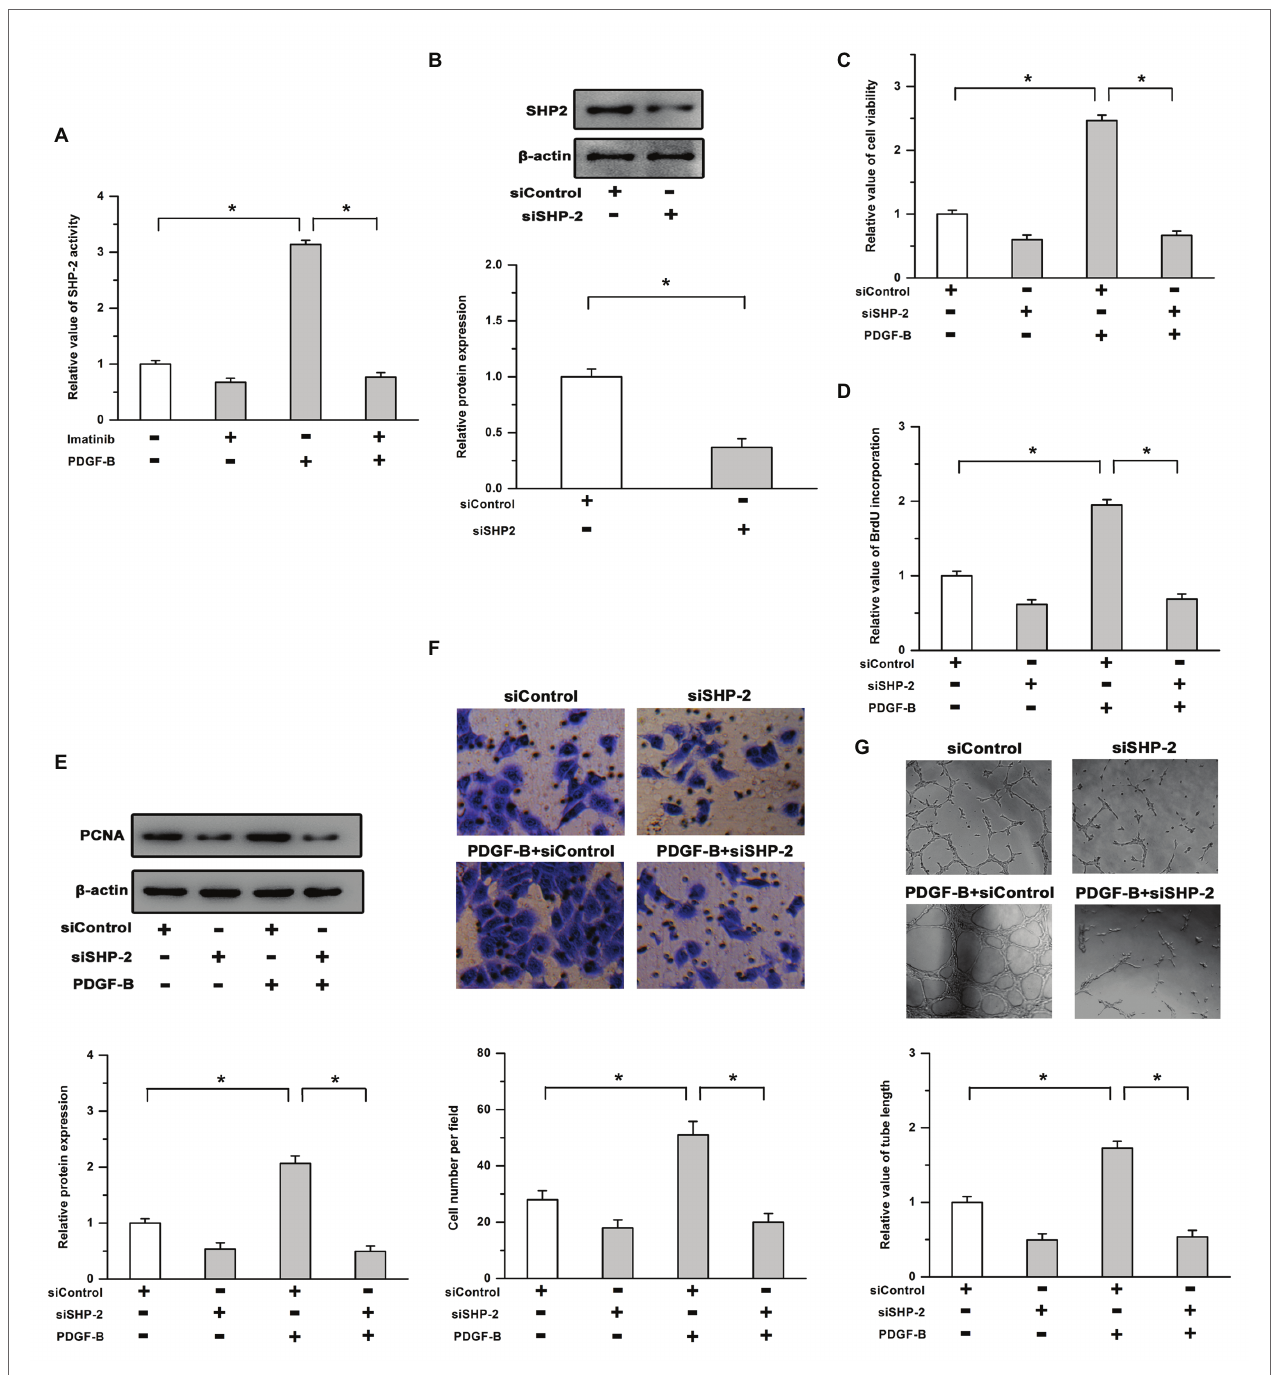
FIGURE 2 | Src homology 2 domain-containing tyrosine phosphatase 2 (SHP-2) is involved in PDGF-B-promoted retinal neovascularization. (A) Treatment with PDGF-B led to increased activity of SHP-2, which was attenuated by the inhibition of PDGFR. (B) The protein levels of SHP-2 were significantly reduced by SHP-2 siRNA. (C,D) PDGF-B increased cell viability (C) and promoted BrdU incorporation (D) which were reversed by knockdown of SHP-2. (E) PDGF-B-induced PCNA expression was mitigated by SHP-2 knockdown. (F,G) The cell migration (F) and tube formation (G) facilitated by PDGF-B stimulation were attenuated by knockdown of SHP-2. *indicates p <